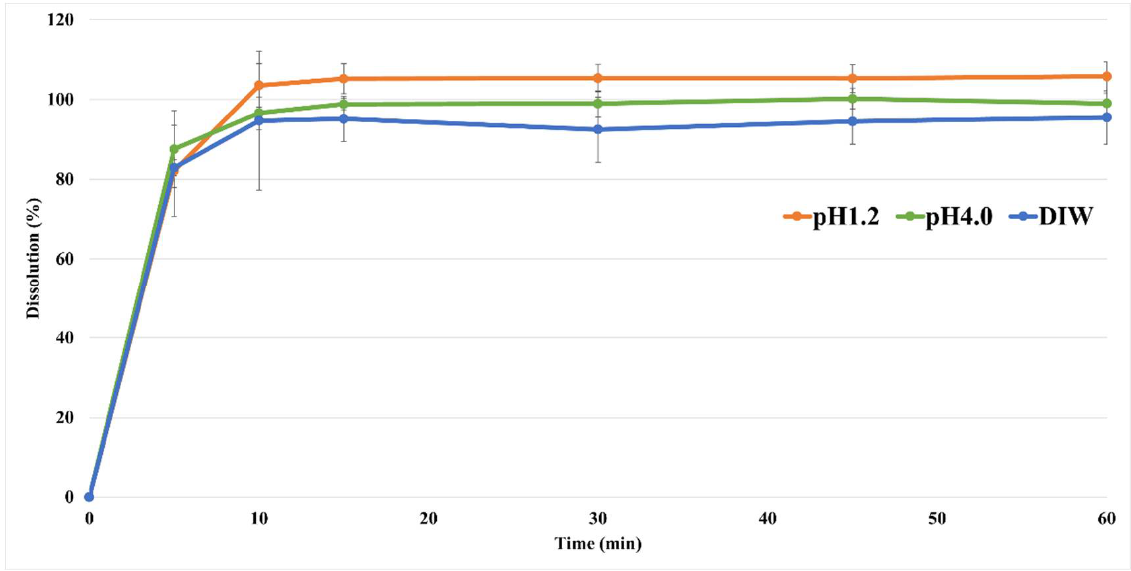
Figure 4. The dissolution profile of nafamostat mesylate from tablets at pH 1.2 and pH 4.0, as well as in DI water.